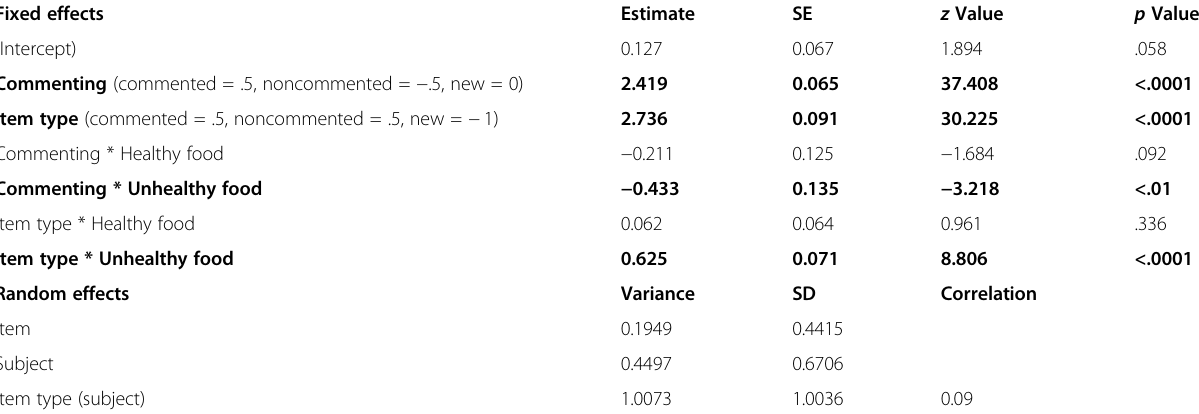
Table 4 Experiment 2: Number of observations: 29,999, 200 items, 150 participants